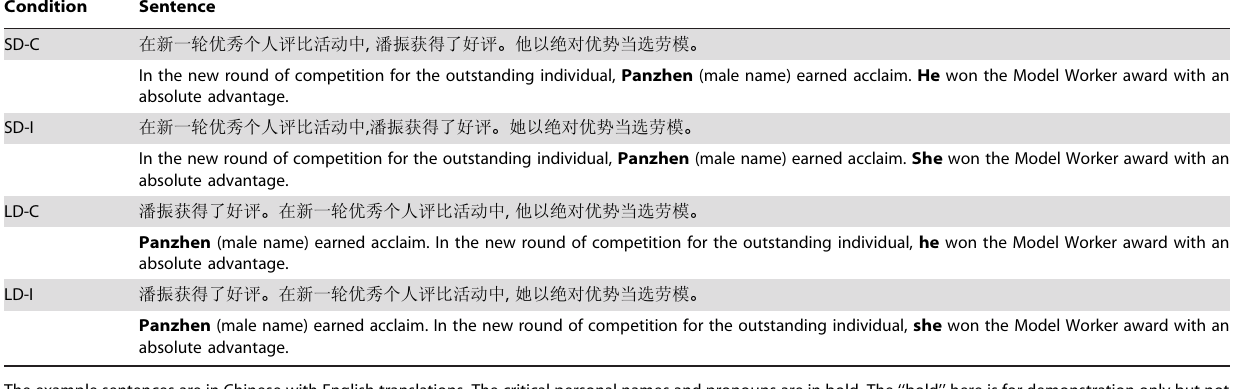
Table 1. Example